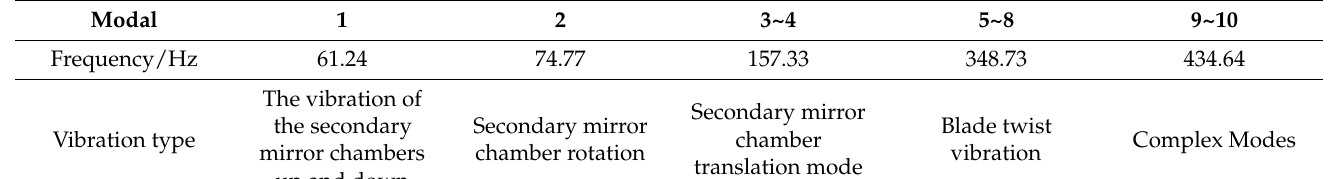
Table 1. First tenth-order modal values of the SMAM.